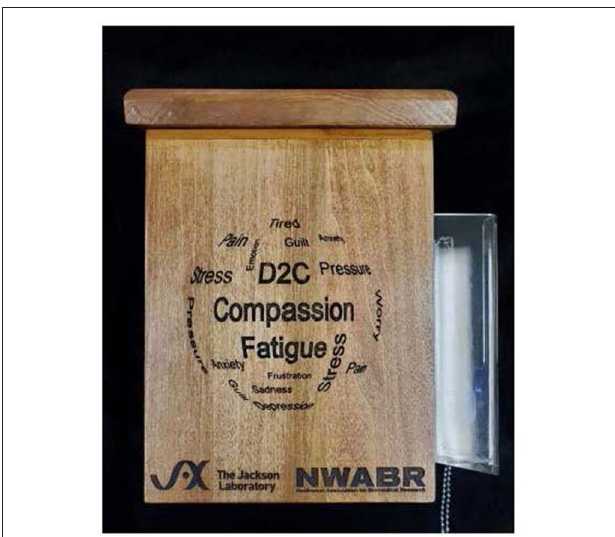
FIGURE 3 | Ken Gordon, Executive Director of the Northwest Association for Biomedical Research (NWABR; Seattle, WA) generously created 20 wooden boxes for this project. Jackson Laboratory (Bar Harbor, ME) donated funds to cover costs of laser engraving. These boxes were laser engraved by Zot Laser Cutting and Engraving (Greenwood, WA) with the D2C Compassion Fatigue Program Logo as well as NWABR and Jackson Laboratory logos. Boxes were polyurethane sealed and are currently in use in vivaria across the University of